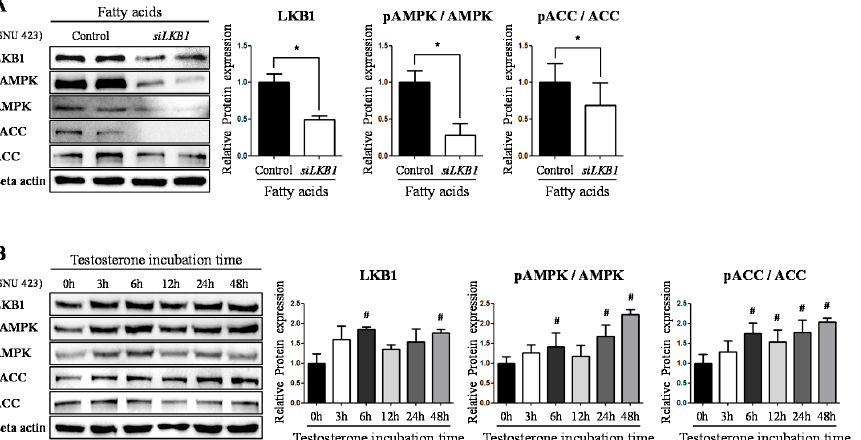
Figure 4. LKB1 influences phosphorylation of AMPK-ACC signaling and was influenced by testos- terone. ( A ) LKB1 knocked down assay by LKB1 specific siRNA ( siLKB1 ) was performed with SNU-423 cells supplemented with fatty acids (Palmitate 330 µM, Oleate 660 µM). The proteins level was determined by Western blotting. The levels of LKB1 expression and phosphorylation of AMPK and ACC was quantified and beta-actin (Mouse) was used as an internal control. ( B ) Testosterone time course assay was performed with SNU-423 cells supplemented with testosterone (10 nM). The proteins level was determined by Western blotting. The levels of LKB1 expression and phosphorylation of AMPK and ACC was quantified and beta-actin (Rabbit) was used as an internal control. The values stand for means +/ − S.D. * p < 0.05 was compared to groups indicated. # p < 0.05 was compared to 0